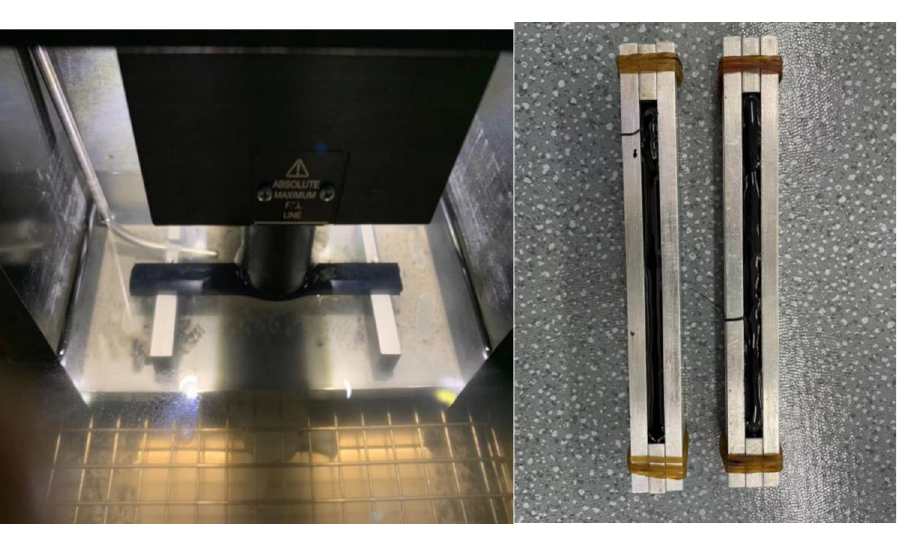
Fig 3. The diagram of the BBR test